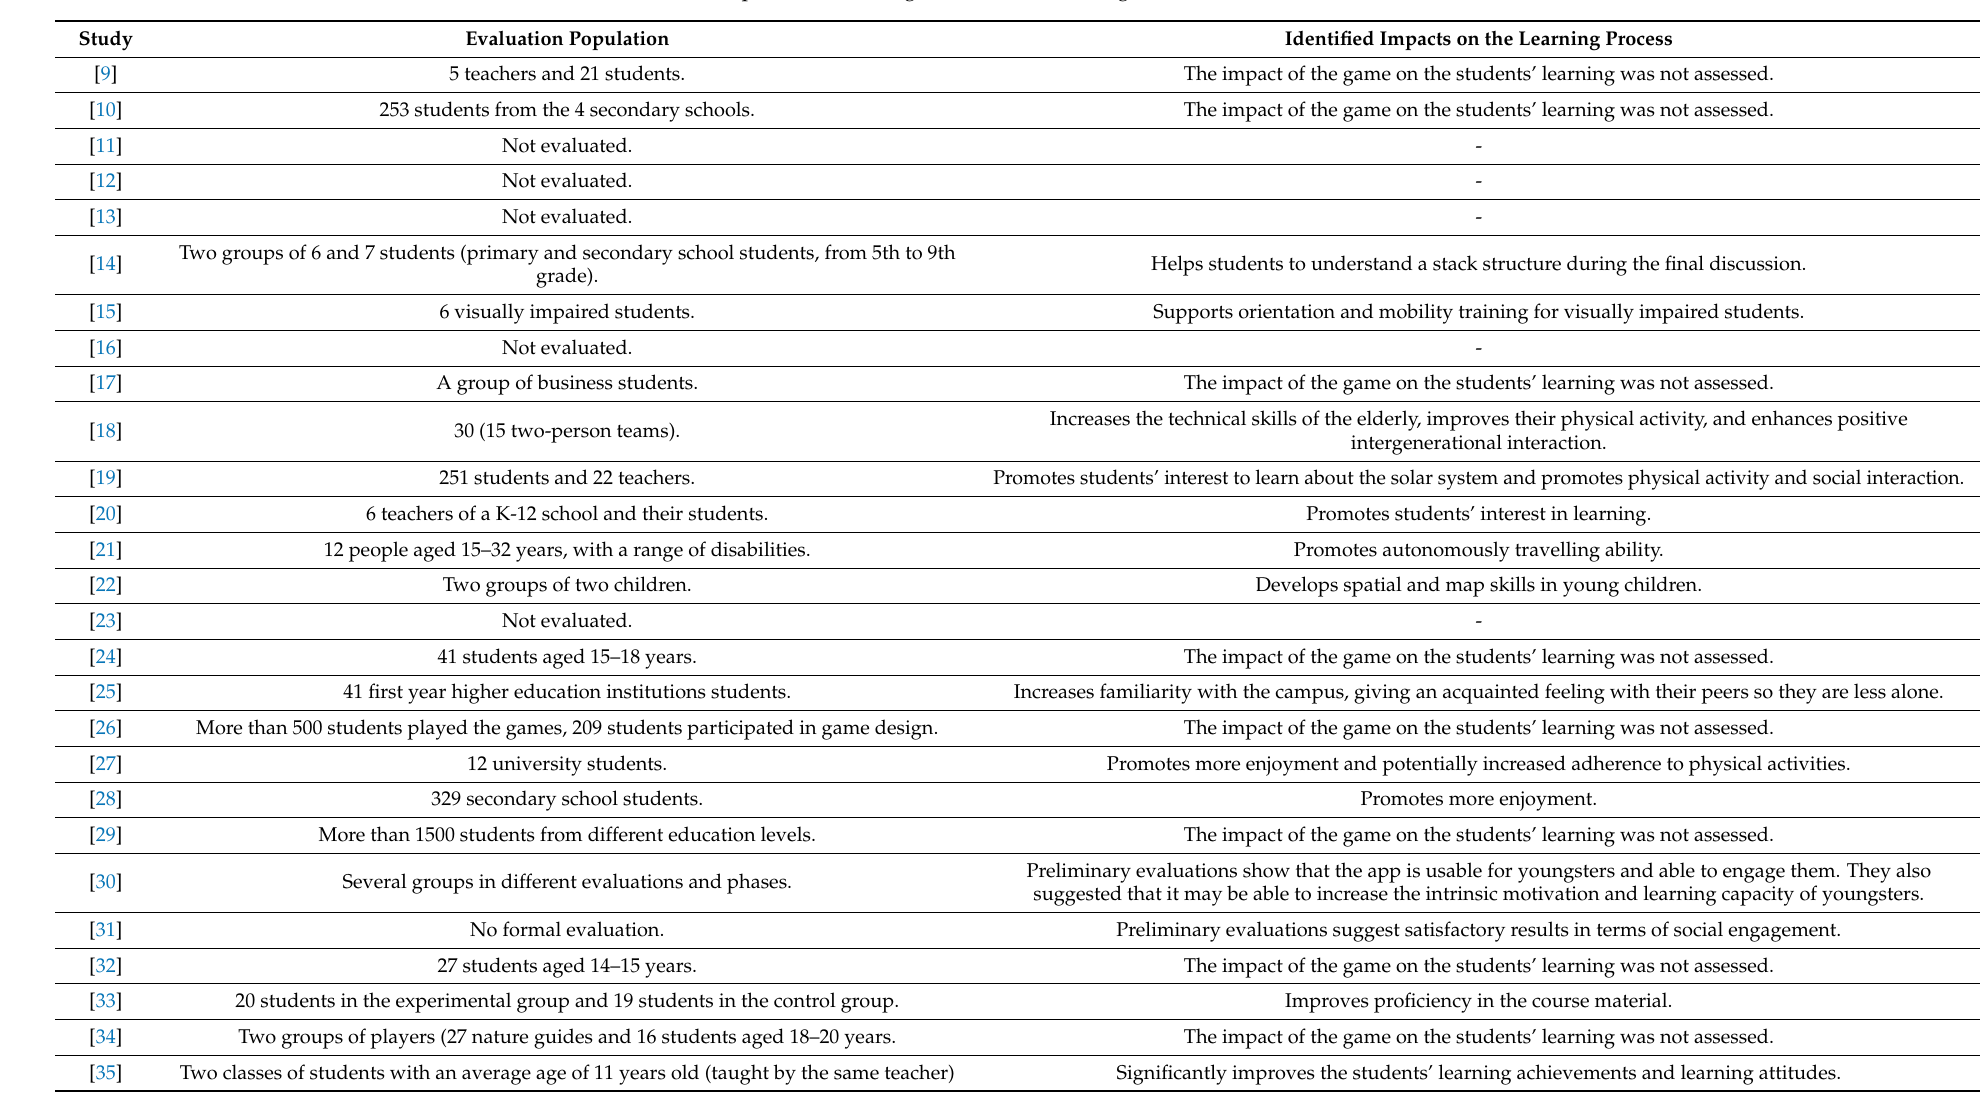
Table 5. Impact and challenges of location-based games for education ( n =